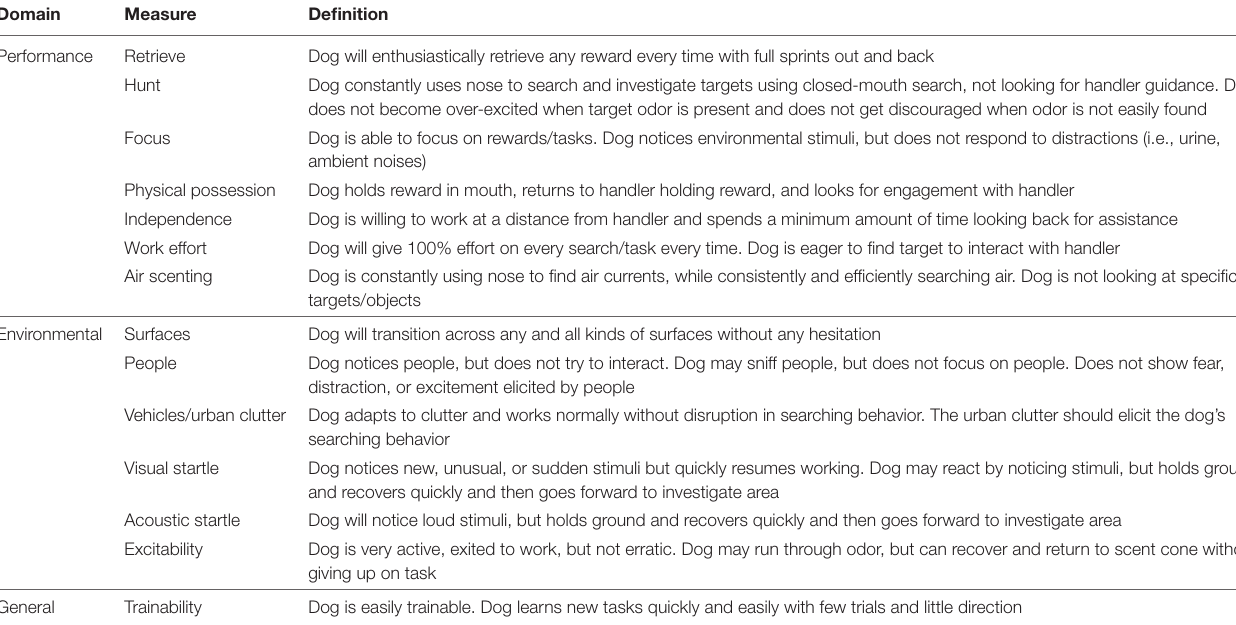
TaBle 1 | Descriptions of measures assessed during performance evaluations, scored on a 1–5 scale from least to most desirable performance.